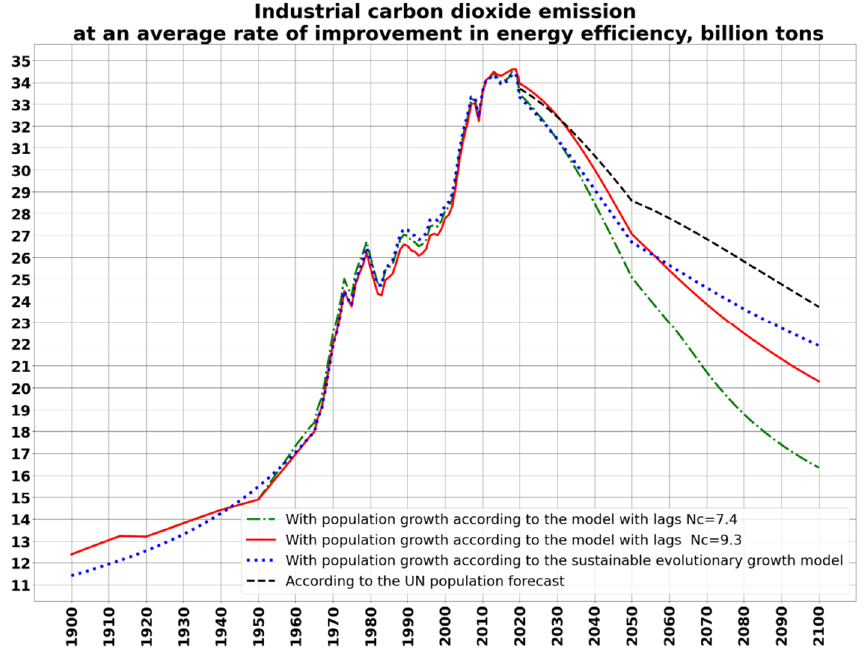
Figure 21. Dynamics of reduction of anthropogenic emissions of carbon dioxide (CO 2 ) into the atmosphere in the 21st century under the conservative scenario of the energy transition.